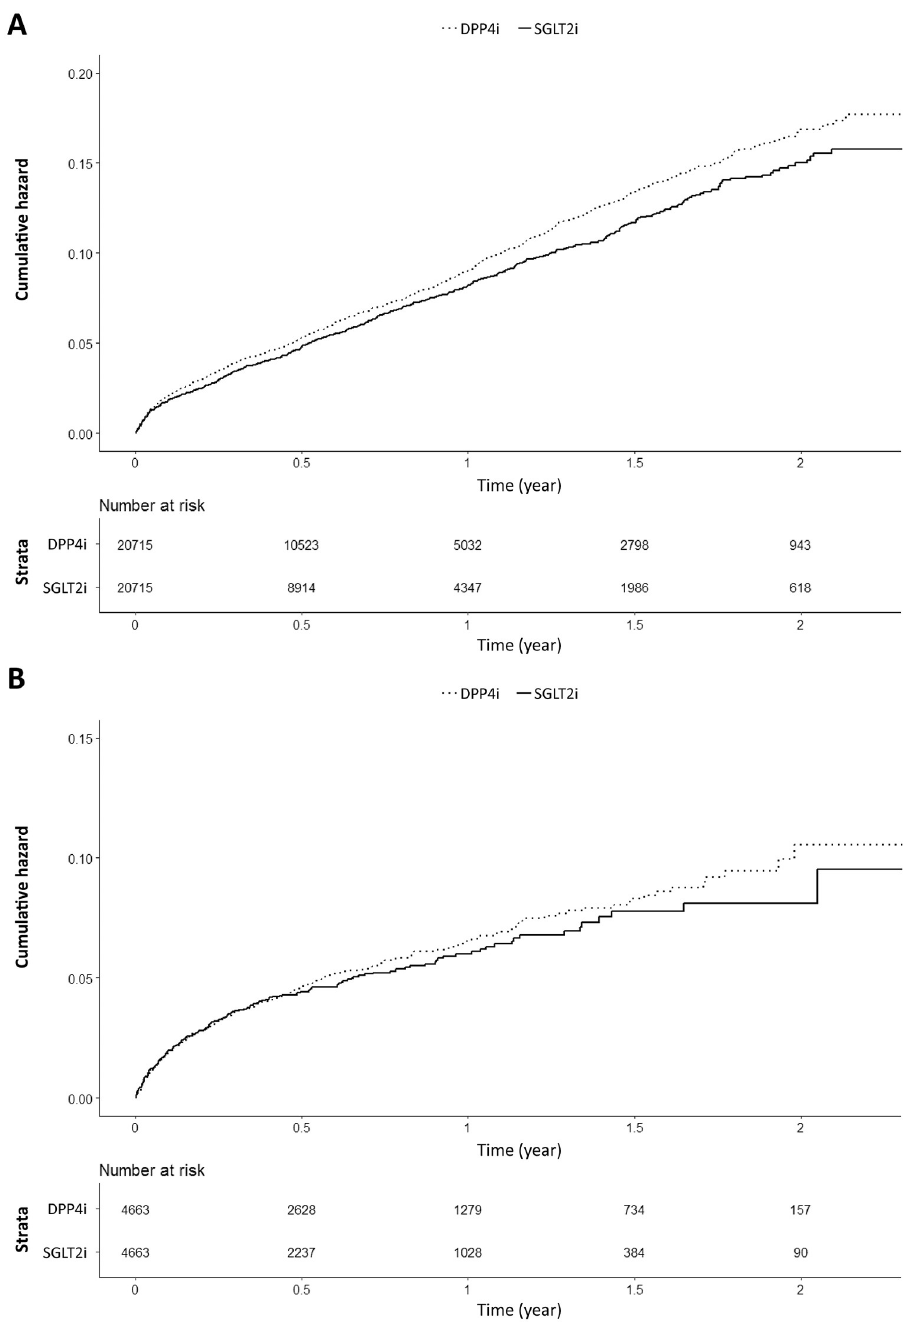
Fig 2. Cumulative incidence (A) and progression (B) of DR in SGLT2i initiators and DPP4i initiators. DPP4i, dipeptidyl peptidase-4 inhibitor; SGLT2i, sodium-glucose cotransporter-2 inhibitor.